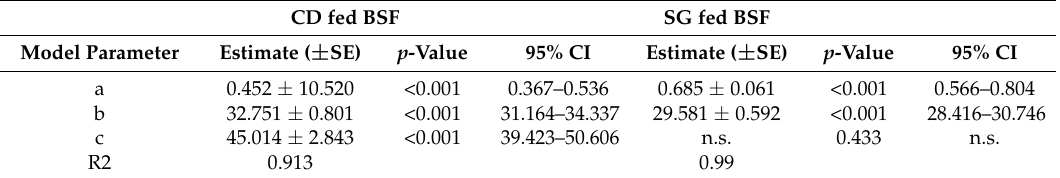
Table 7. Estimates of linear model parameters describing the relationship between temperature and pupal developmental time of black soldier fly reared on two different organic